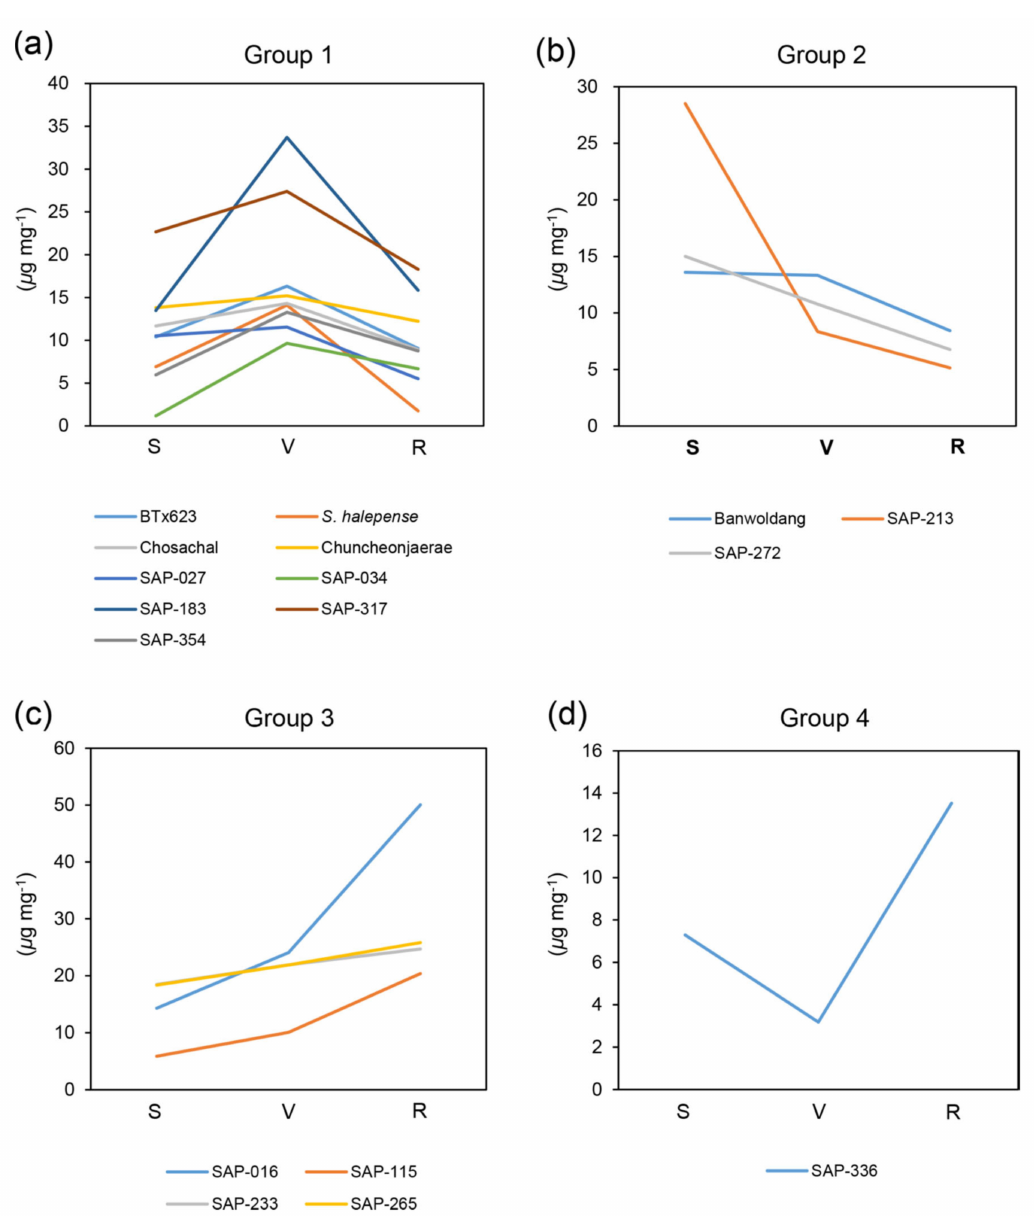
Figure 2. Grouping analysis of dhurrin contents by di ff erent developmental stages. The dhurrin contents of all the accessions were classified into four groups according to their patterns. ( a ) Group 1. ( b ) Group 2. ( c ) Group 3. ( d ) Group 4. A separate graph showing the dhurrin contents for each accession is given in the Figure S2. Y -axis, amount of dhurrin ( µ g mg − 1 ). X -axis, developmental stage. S, seedling stage (Z15 / 20); V, vegetative stage (Z19 / 47); R, ripening stage (Z19 / 87). n = 3 or